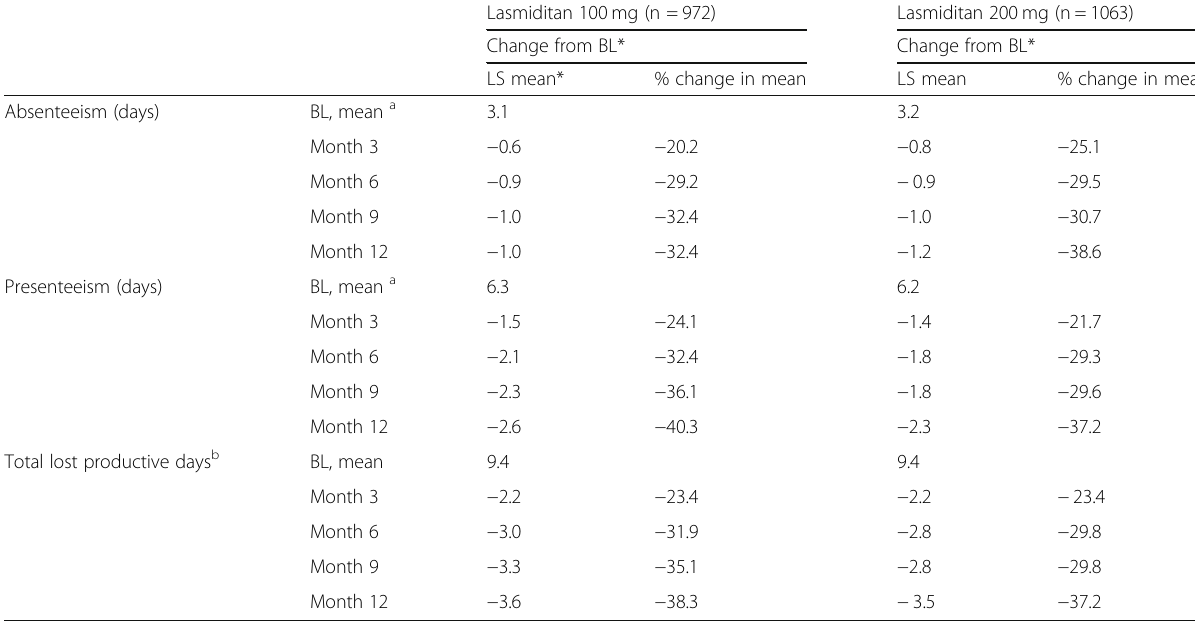
Table 3 Change from baseline in MIDAS absenteeism (days), presenteeism (days), and total lost productive